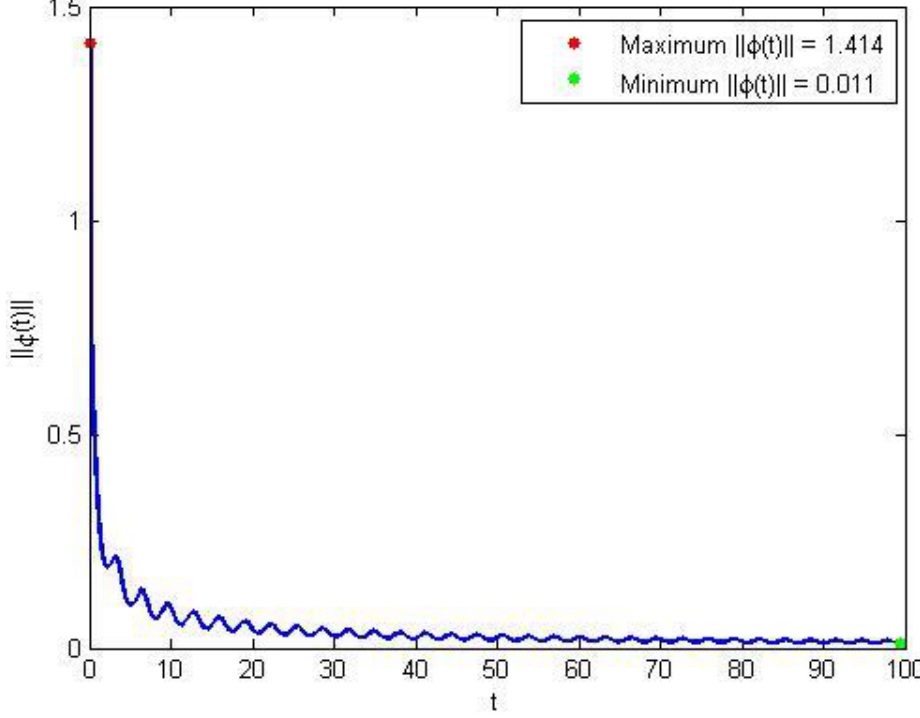
Figure 14. || ϕ ( t ) || for system (10), with α = 0.5, ρ = 1.5, and w ( t ) = [ 2 sin ( t )] T Figure 14. ‖𝜑(𝑡)‖ for system (10), with 𝛼 = 0.5 , 𝜌 = 1.5, and 𝑤(𝑡) = [2 𝑠𝑖𝑛(𝑡)] 𝑇 .